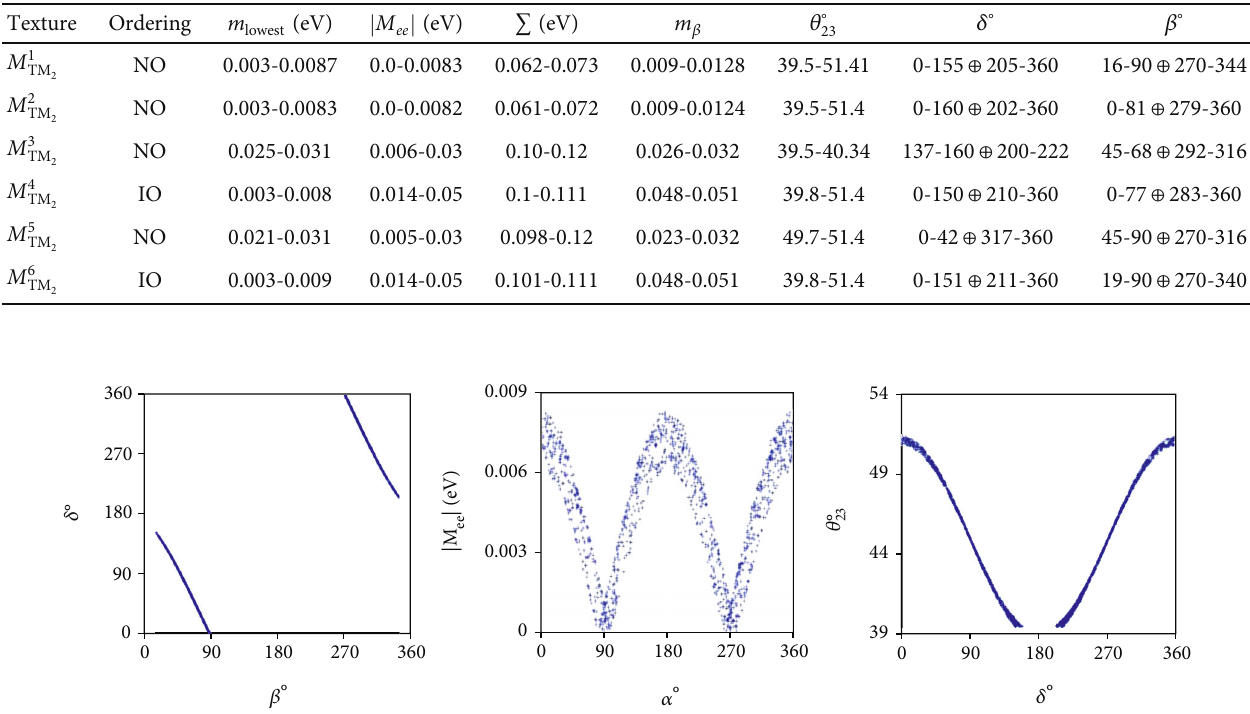
Table 4: Numerical predictions for viable textures having one equality in M double beta decay bounds along with neutrino oscillation data are incorporated).